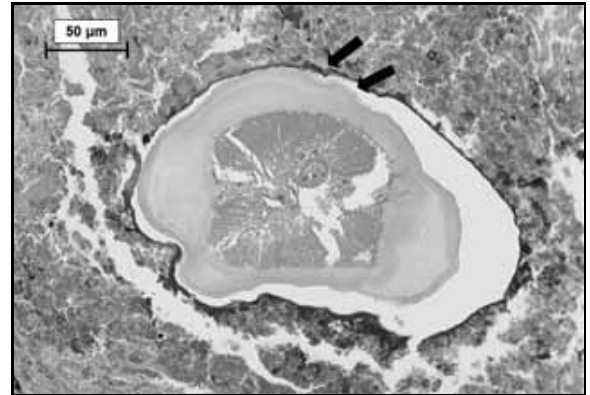
Figura 4 – Microfotografia em detalhe do parasita, na qual é possível ver as estriações transversais da cutícula (setas) e órgãos internos, dois úteros e um tubo digestivo (pentacrômico de Movat).